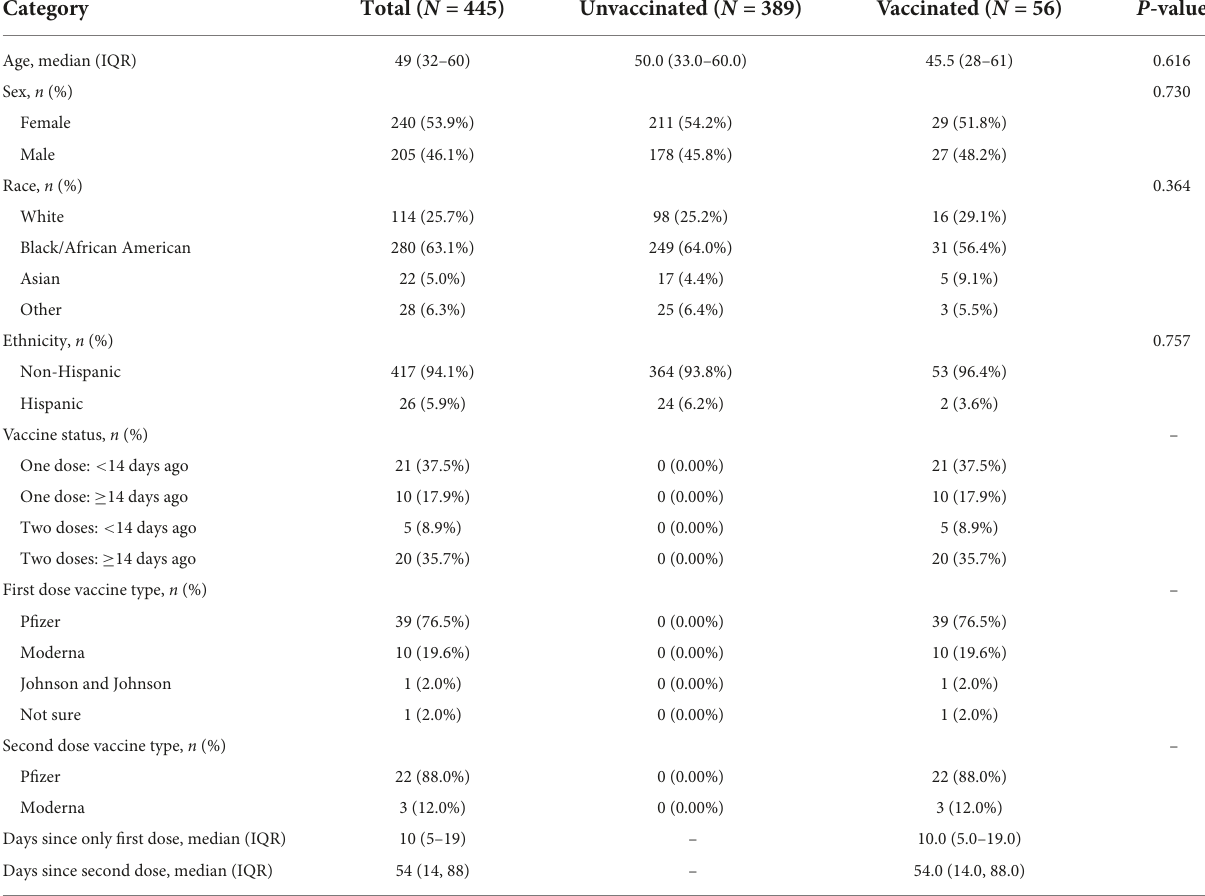
TABLE 1 Demographics of SARS CoV-2 (+) unvaccinated and vaccinated [partially ( n = 36) and fully ( n = 20)]